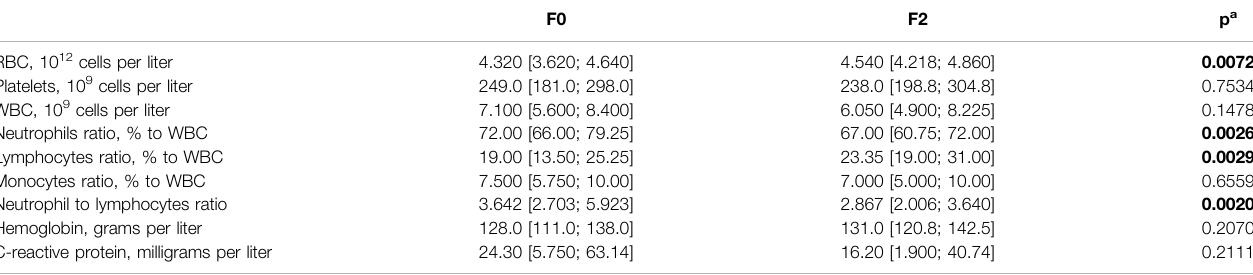
TABLE 5 | Main blood and biochemical parameters in organic mental spectrum disorders (F0, n = 41) and schizophrenia spectrum disorders (F2, n = 65) subgroups, median [IQR]. F0